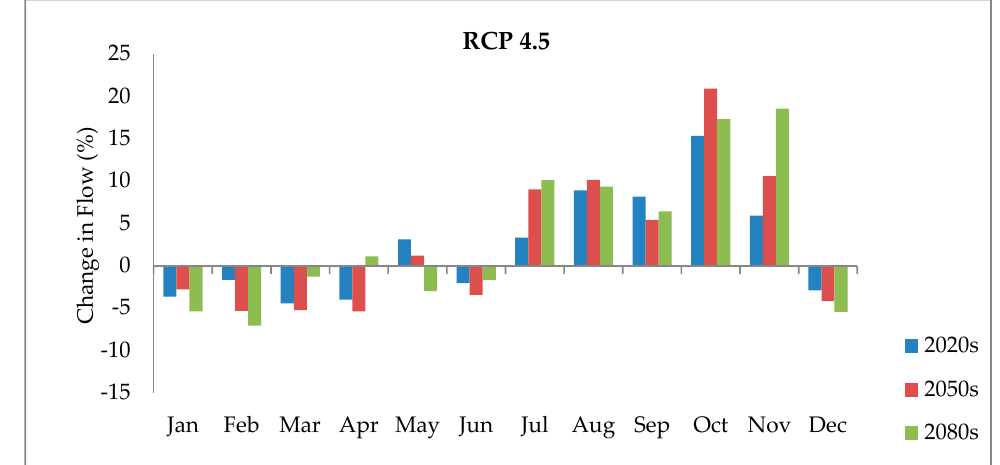
Figure 15. Change in stream flow under RCP4.5 scenario compared to the baseline period (1961–1990).